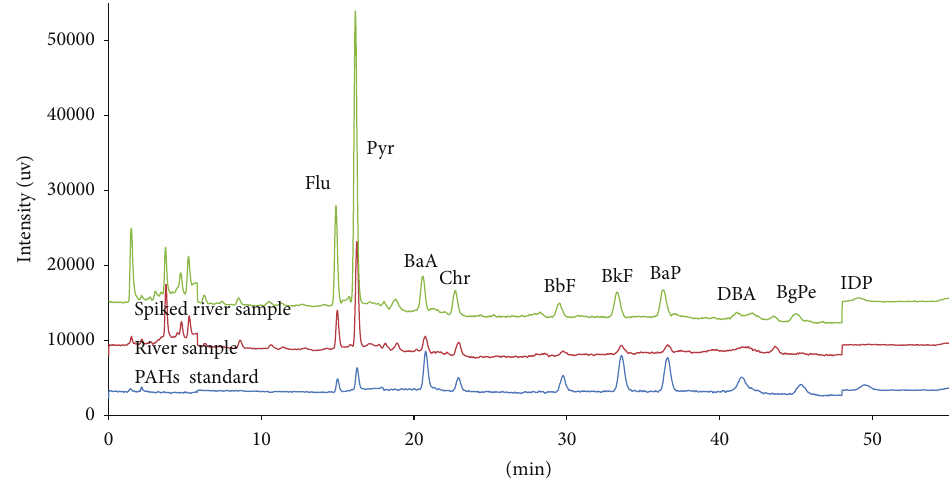
Figure 7: Chromatograms of PAHs standard, river water sample, and spiked river water